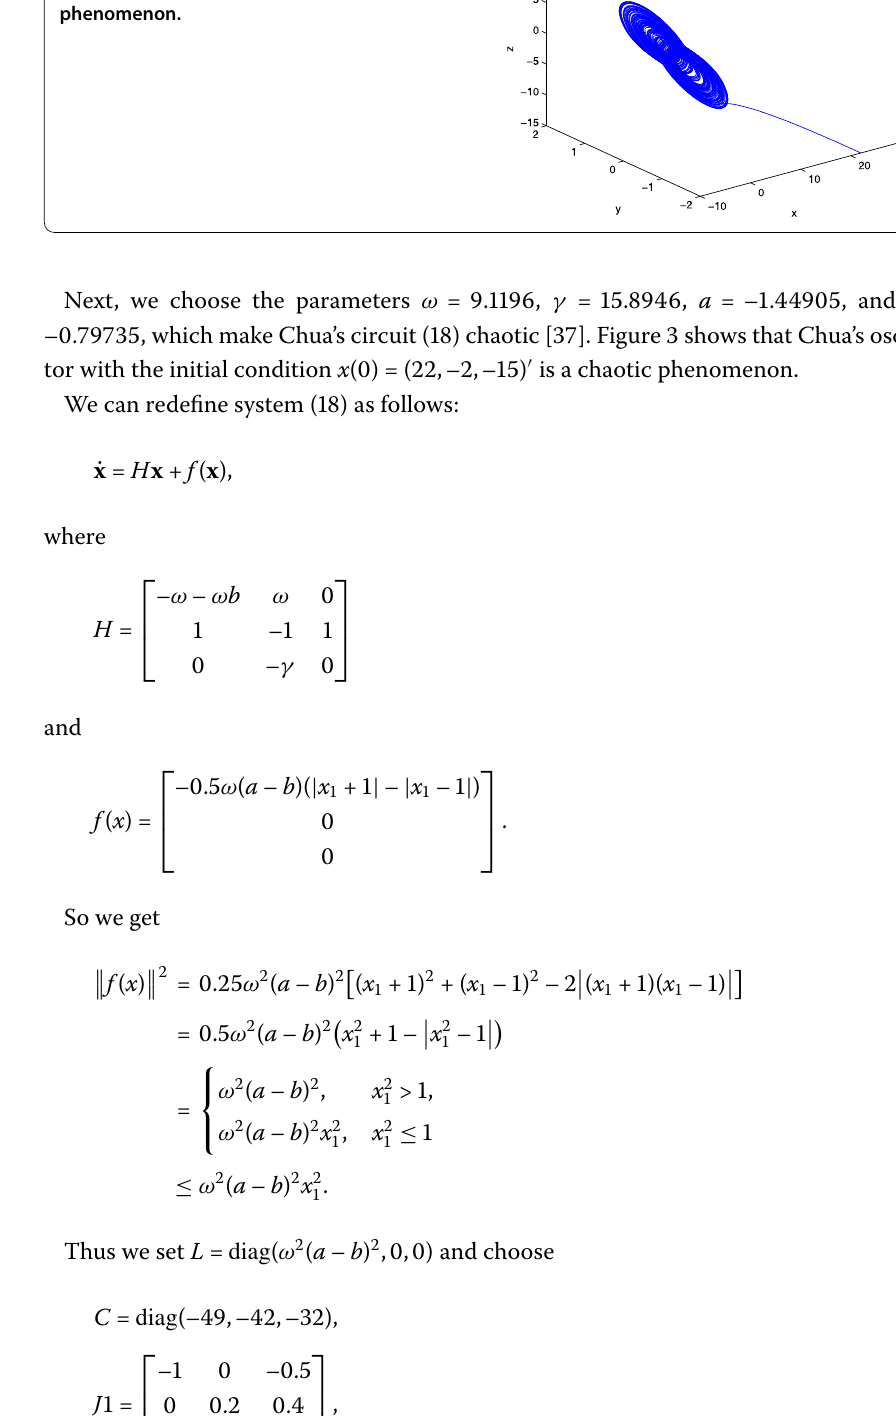
Figure 3 The Chua’s oscillator with the initial condition x (0) = (22,–2,–15) (cid:2) is a chaotic